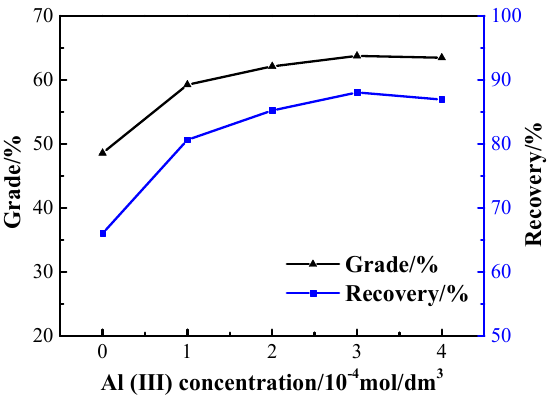
Figure 5. Effect of Al (III) ions concentration on Sn grade and recovery of unfloated particles (at pH 8.0 and NaOL concentration of 5 × 10 −5 mol/dm 3 ).